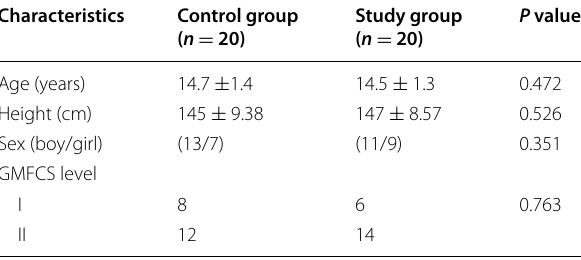
GMFCS Gross Motor Function Classification System Unpaired t tests was used for the comparison between basic features between the two groups